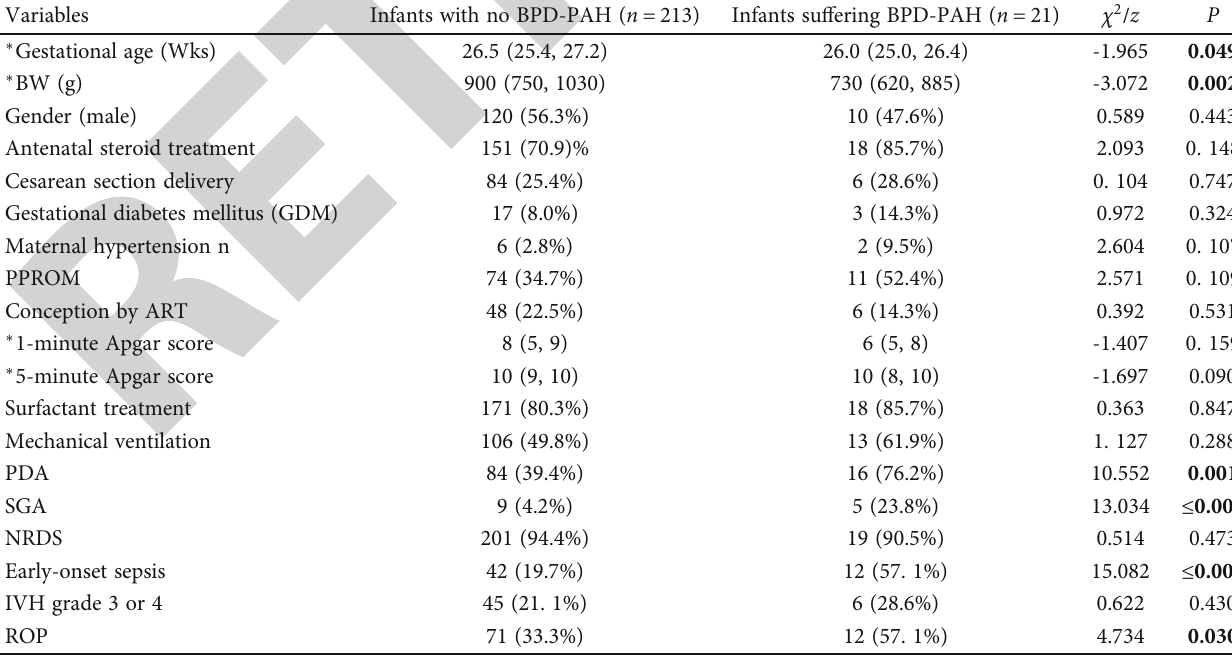
Figure 1: Infant selection fl owchart. Table 1: Clinical characteristics by pulmonary arterial hypertension associated with bronchopulmonary dysplasia. Variables Infants with no BPD-PAH ( n = 213